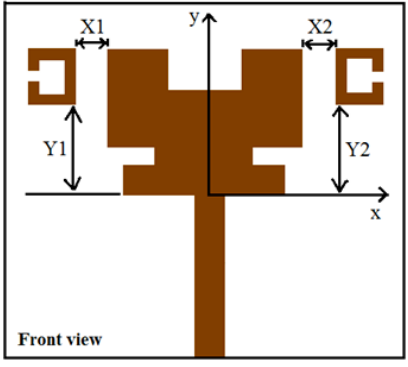
Figure 1. PE1 and PE2 positions with the radiating